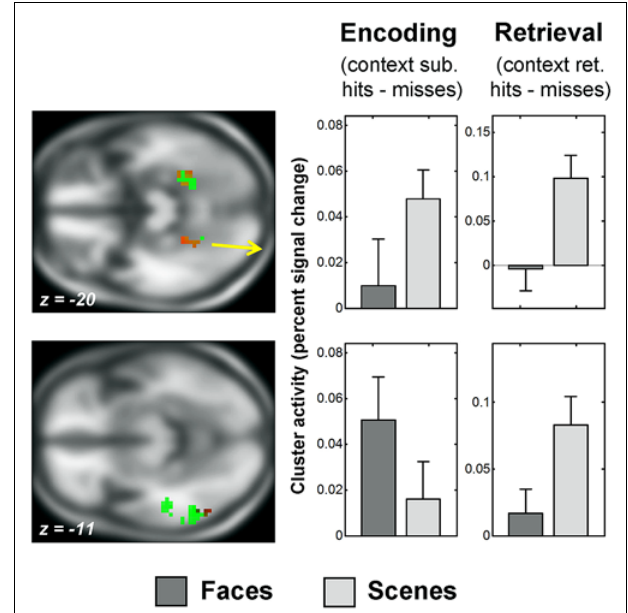
FIGURE 3 | Recapitulation of encoding activity during face context retrieval. The sections show the overlap of selective context retrieval effects (overlap shown in red) with selective context encoding effects (shown in green), displayed on the average anatomicalT1 image from this sample.Thresholds for display are those used in the overlap analysis (see Behavioral Analysis). Above: left middle temporal gyrus region which showed face-selective encoding activity and face-selective retrieval activity (peak x = − 63, y = − 34, z = − 5). Below: posterior subcortical region which showed scene-selective encoding activity and face-selective retrieval activity (peak x = 24, y = − 31, z = 19). Encoding activity and encoding-retrieval activity for this region were masked with a gray matter mask for display purposes (see Successful Encoding Effects and Recapitulation of Encoding Activity at Retrieval for details). Plots show percent signal change successful context encoding effects (left) and successful context retrieval effects (right) averaged across the respective significant clusters of overlapping activity peaks (see Recapitulation of Encoding Activity at Retrieval). Error bars represent standard errors of the mean. Percent signal change was calculated as percent of the cluster overall mean signal change, adjusted for the height of a single trial regressor (http://marsbar.sourceforge.net/faq.html).Y-axes show percent signal change differences for context encoding and retrieval effects as indicated; arbitary units. Note that the scaling is not comparable for the encoding and retrieval plots. See fMRI Analysis and Data Analysis Strategy for details of contrasts, and fMRI Findings for details of clusters.